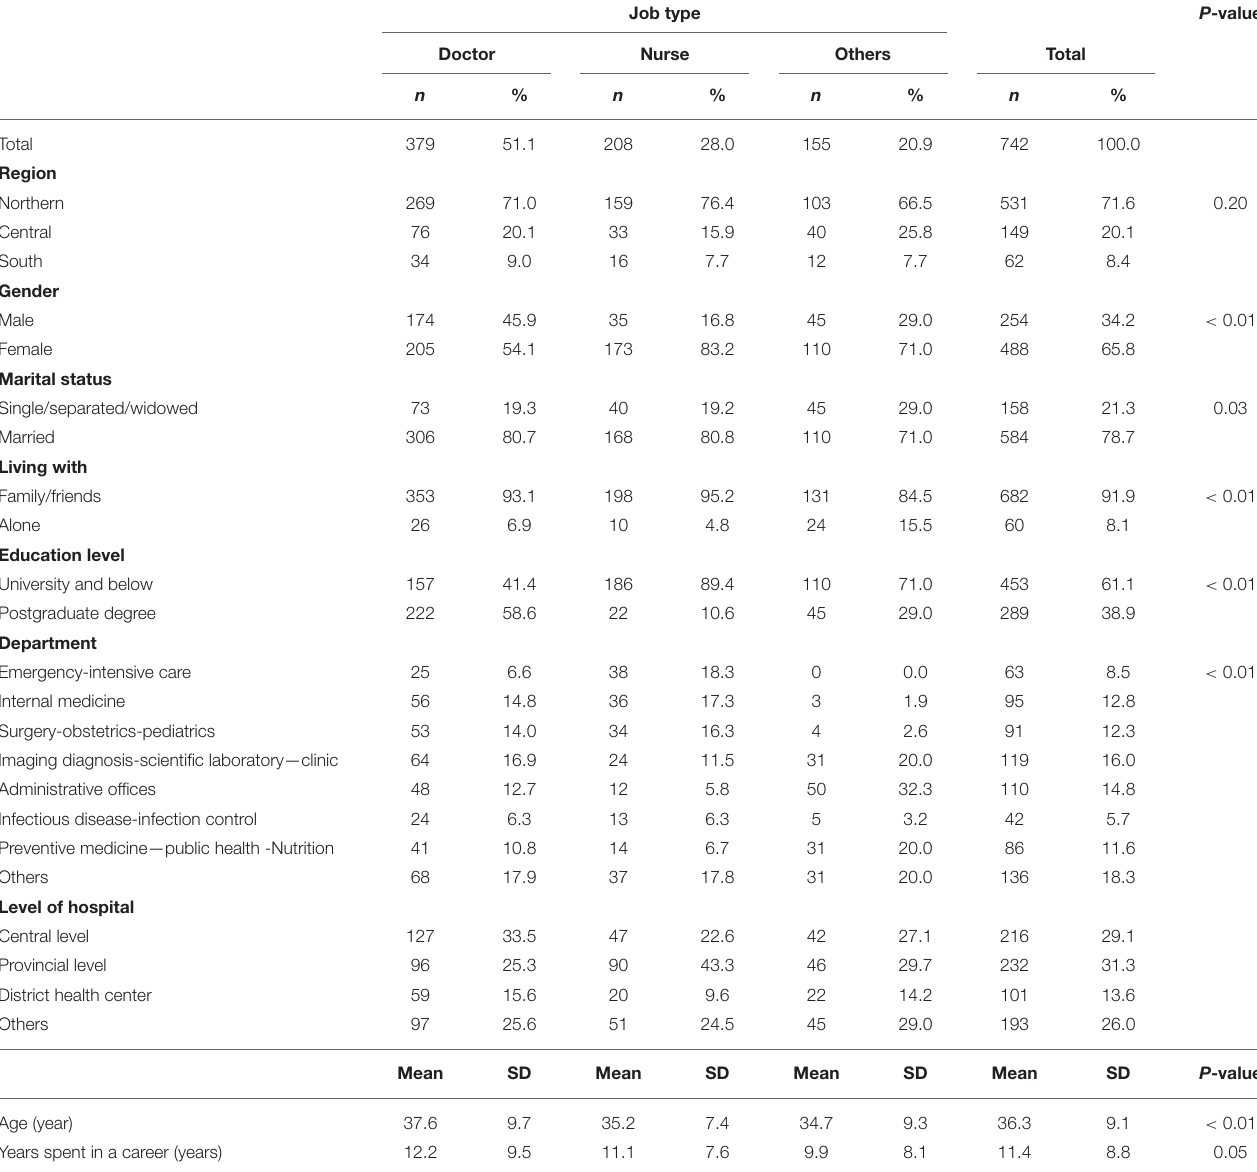
TABLE 1 | Demographic characteristics of